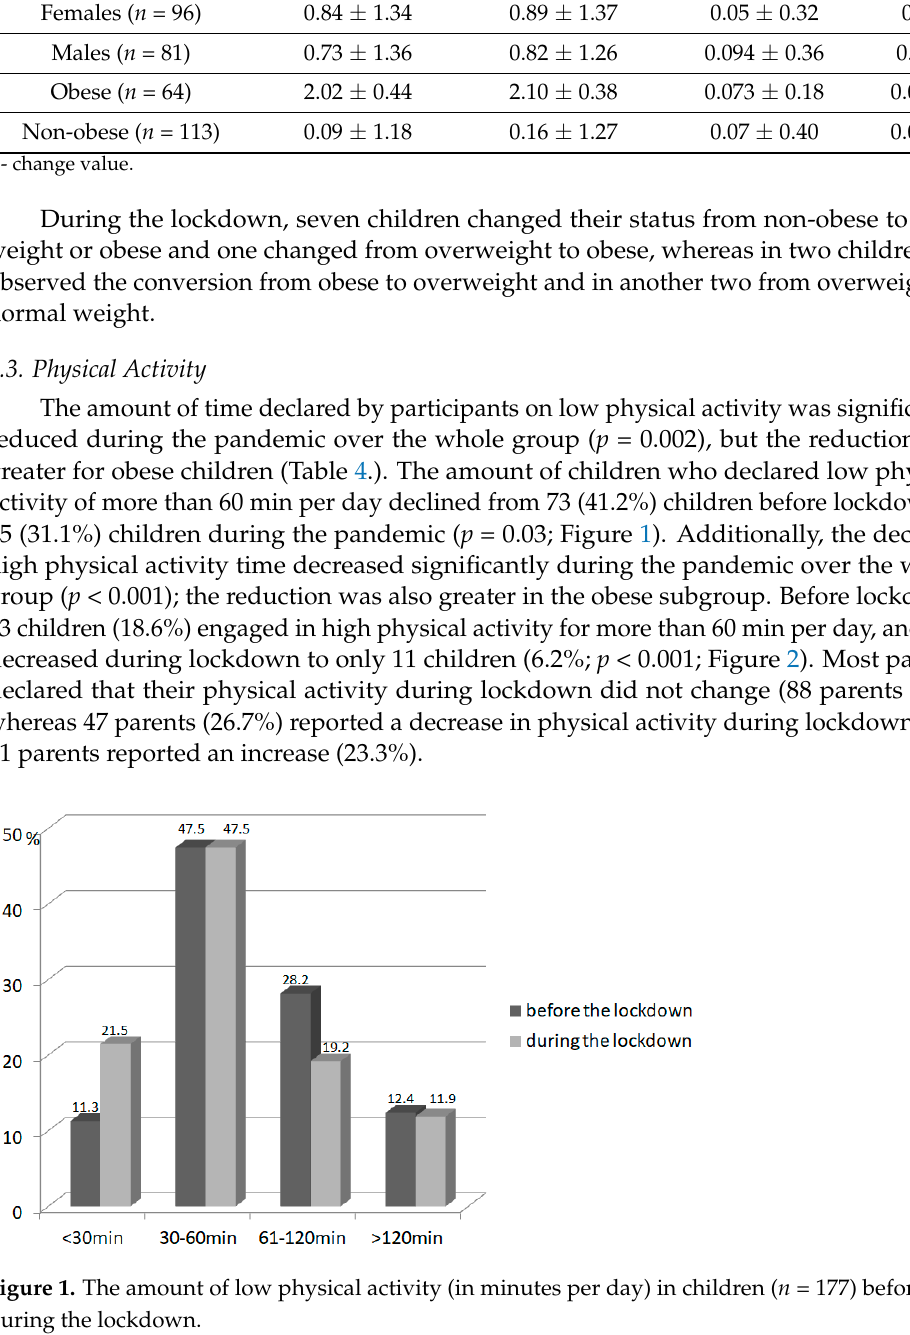
Figure 2. The amount of high physical activity (in minutes per day) in children (n = 177) before and during the lockdown. 3.4. Sleep and Screen Time The study revealed that during the pandemic, the length of sleep and screen time for children increased. During the lockdown, more children slept for more than 8 h than before (n = 107, 60.4% children vs. n= 83, 46.9% children; p = 0.007) and less slept less than 6 h (n = 4, 2.3% children vs. n = 13, 7.3% children; p = 0.02; Figure 3). A dramatic increase in children spending more than 5 h per day using computers and other electronic devices during the